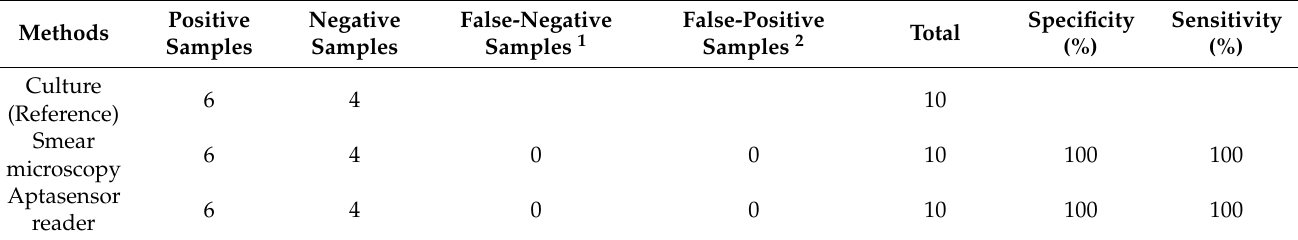
Table 3. Sensitivity and specificity of smear microscopy and aptasensor methods used to identify M. tuberculosis in clinical sputum samples that were obtained from